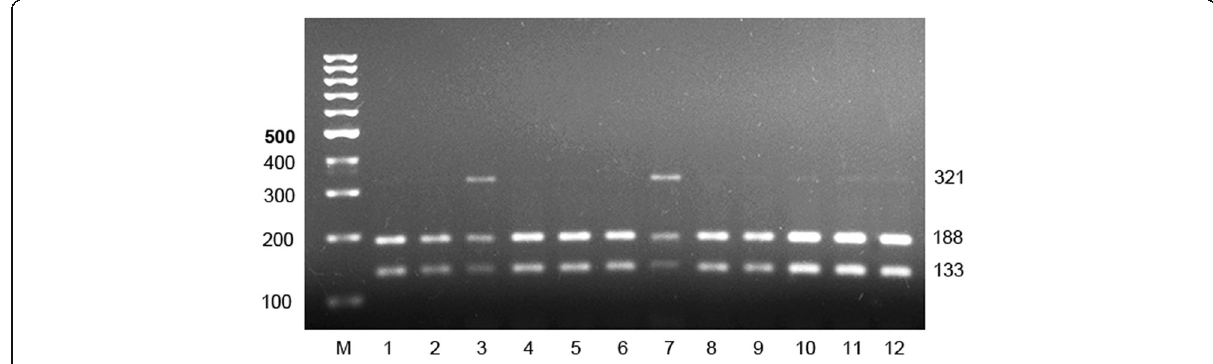
Fig. 1 PCR-RFLP detection of SCN1A gene mutation p.Ala1783Thr (c.5347G>A). М – DNA Ladder GeneRuler 100 bp (Thermo Fisher Scientific, USA); 1,2,5,6,8-11 – homozygotes by normal allele c.5347G>A (188 and 133 bp DNA fragments length); 3 and 7 – c.5347G>A heterozygote genotype (321, 188, and 133 bp DNA fragments